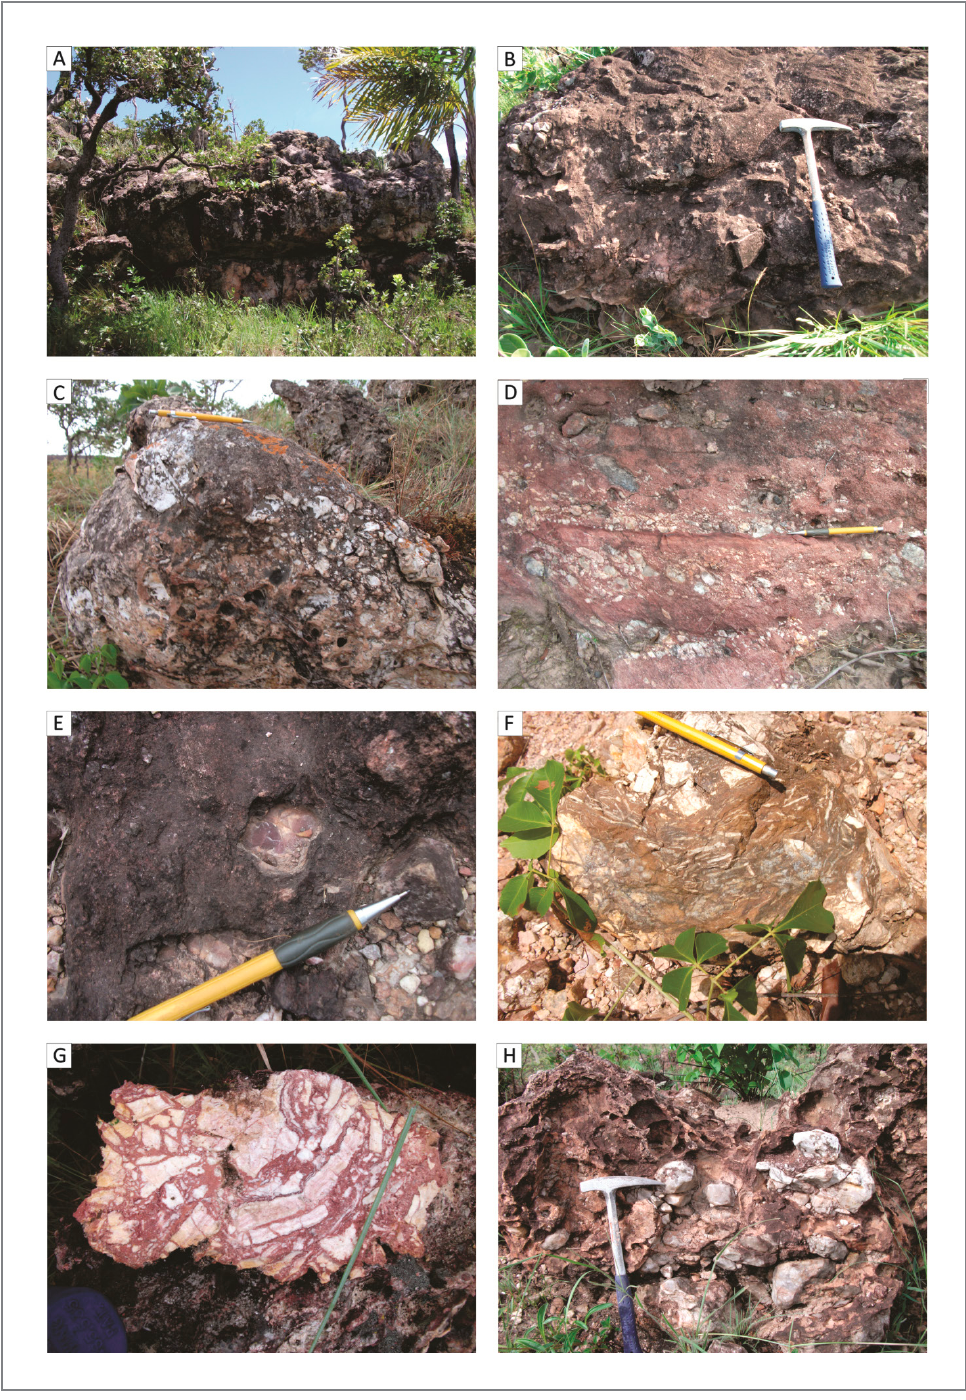
FIGURE 4 - Features of the breccia outcrops. (A) Typical siliceous breccia outcrop in the form of bank-like rock bodies. A bed of metasandstone lies under the breccia unit. (B) Bank-like breccia formed of pebble-sized clasts. A metasandstone layer showing cross-bedding overlies the breccia unit. (C) Roughly stratified breccia bank, containing siliceous rock fragments of different sizes. (D) Pebbles and granules of metachert embedded in metasandstone. Note that clasts are roughly imbricated along the bedding. (E) Matrix-supported breccia containing cobble- and pebble-sized siliceous fragments embedded in metasandstone. (F) Breccia containing clasts and laths of quartz set in a limonitic siliceous cement. (G) Breccia showing jigsaw to chaotic structure and many lath-like fragments. (H) Cavernous structure in breccia due to partial plucking out of fragments by